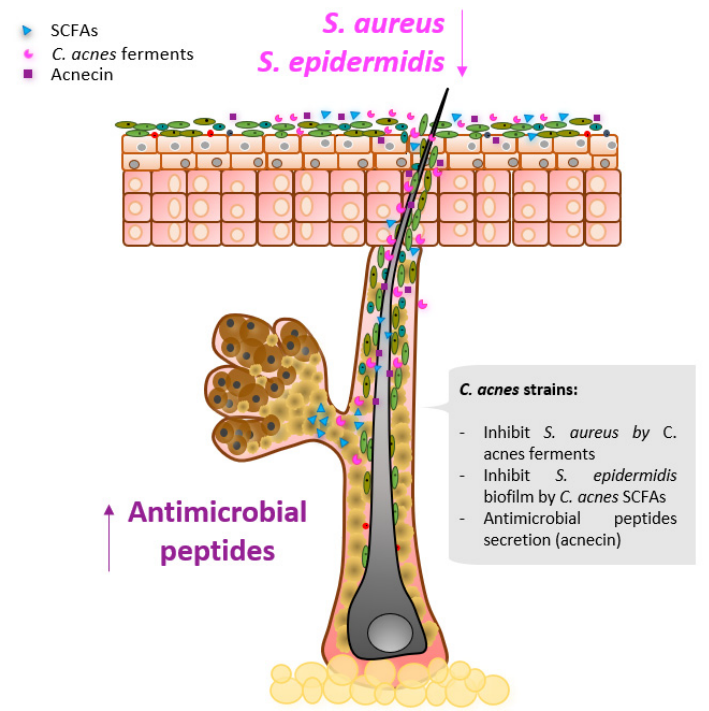
Figure 4. Selected Cutibacterium acnes major contributions in niche modulation.